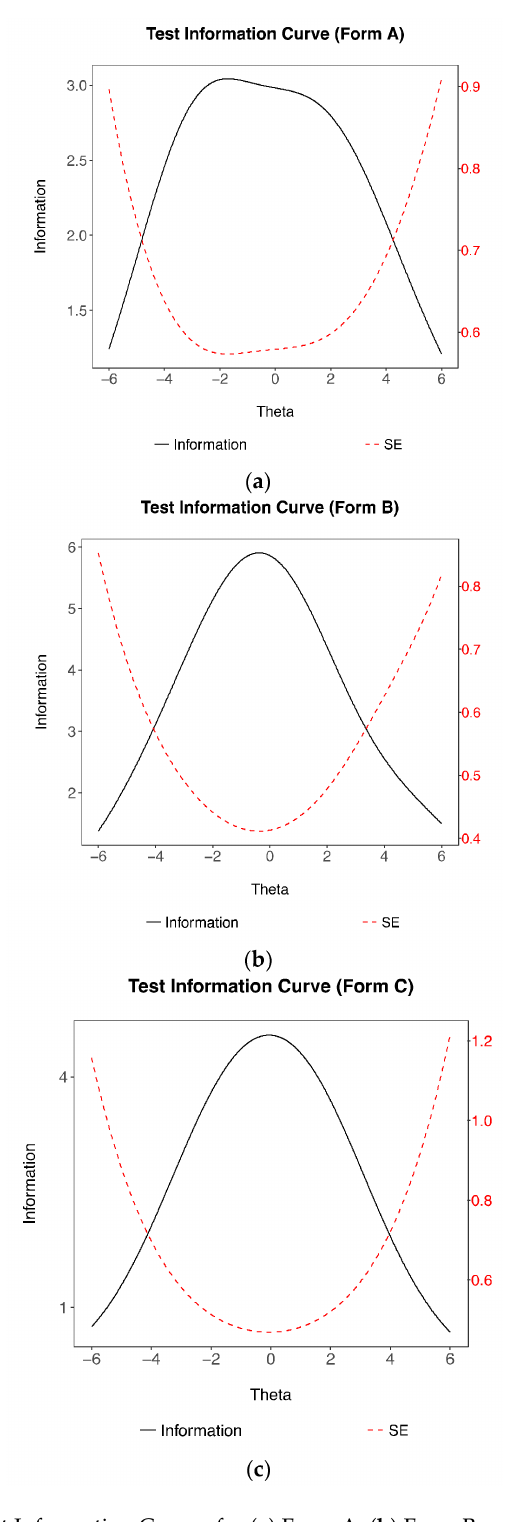
Figure 3. Test Information Curves for ( a ) Form A, ( b ) Form B and ( c ) Form